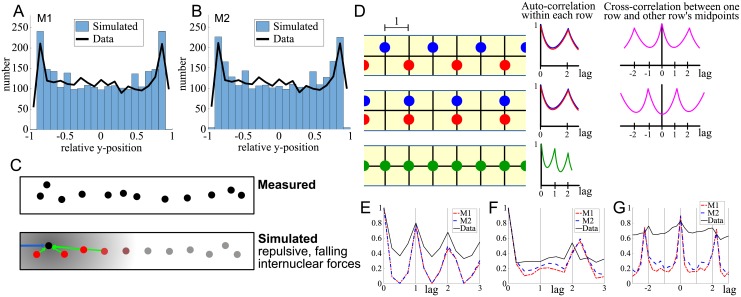
Pattern along the x- and y-axis.A and B: Comparison between the measured and simulated histogram of relative y-positions for M1 and M2 using the calibrated parameter values (Table 1). C: Example cell with the positions of the nuclei as measured (upper row) and determined by M1 (lower row). In the lower row, the forces felt by a nucleus near the pole (black) is shown. Blue arrow represents the pole force on the black nucleus; green arrows show internuclear forces; side forces are not depicted. The strength of internuclear forces is represented by varying shades of red. Gray shading represents the reach of the internuclear force. D: Assuming a perfect pattern of zig-zags (top row), pairwise files (middle row) or of equally spaced single files (bottom row), the resulting auto-, or cross-correlation is depicted on the right. E: The auto-correlation function predicted and measured for SF cells. F: The predicted and measured auto-correlation function for each row in DF cells. G: The predicted and measured cross-correlation between the left row and the middle points of the right row in DF cells. For details see Methods.